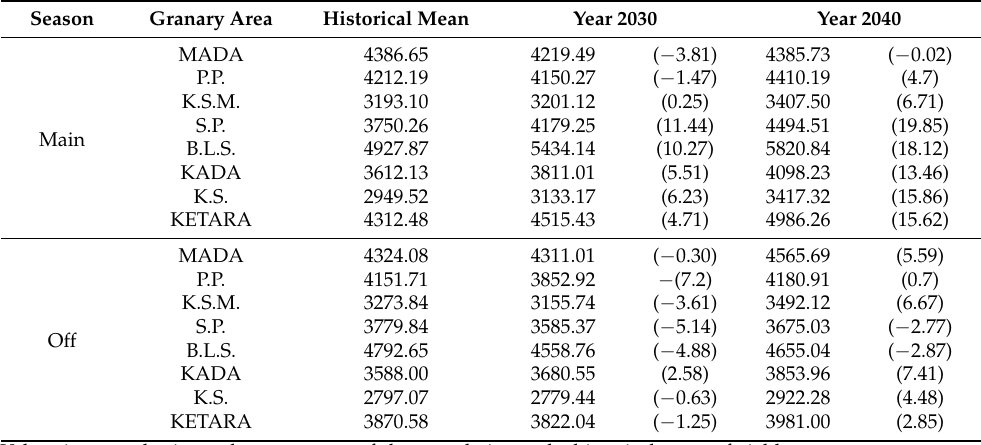
Table 8. Forecasted yield for the years 2030 and 2040 relative to the sample means. Season Granary